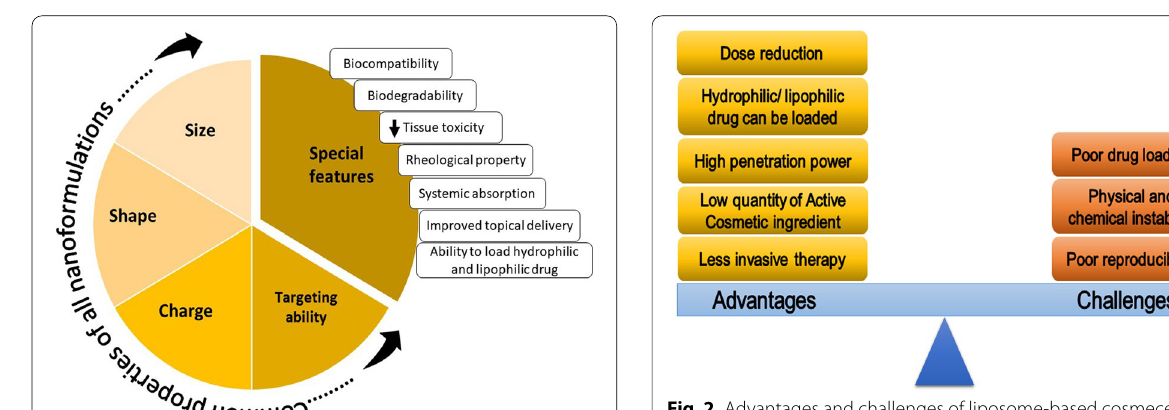
Fig. 2 Advantages and challenges of liposome-based cosmeceutical